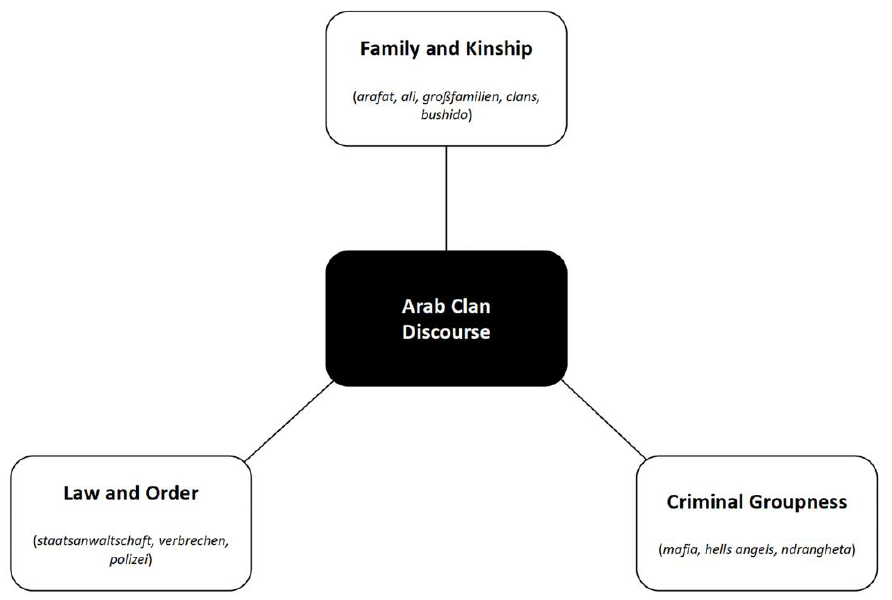
Figure 2. Macro topics that constitute the German media discourse about ‘Arab clans’ (2010– 2019).